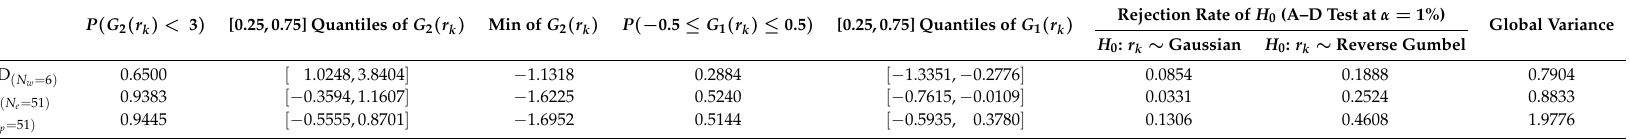
Table 1. Characteristics of the distribution of the detection statistic r k (one MC